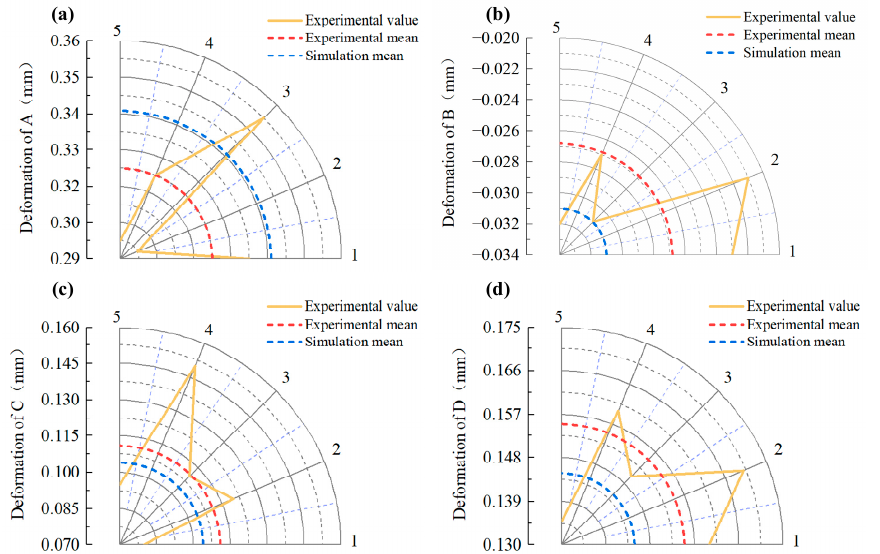
Figure 20. Comparison of quenching deformation results in key positions of gears (as shown in Figure 13): ( a ) A; ( b ) B; ( c ) C; ( d ) D.